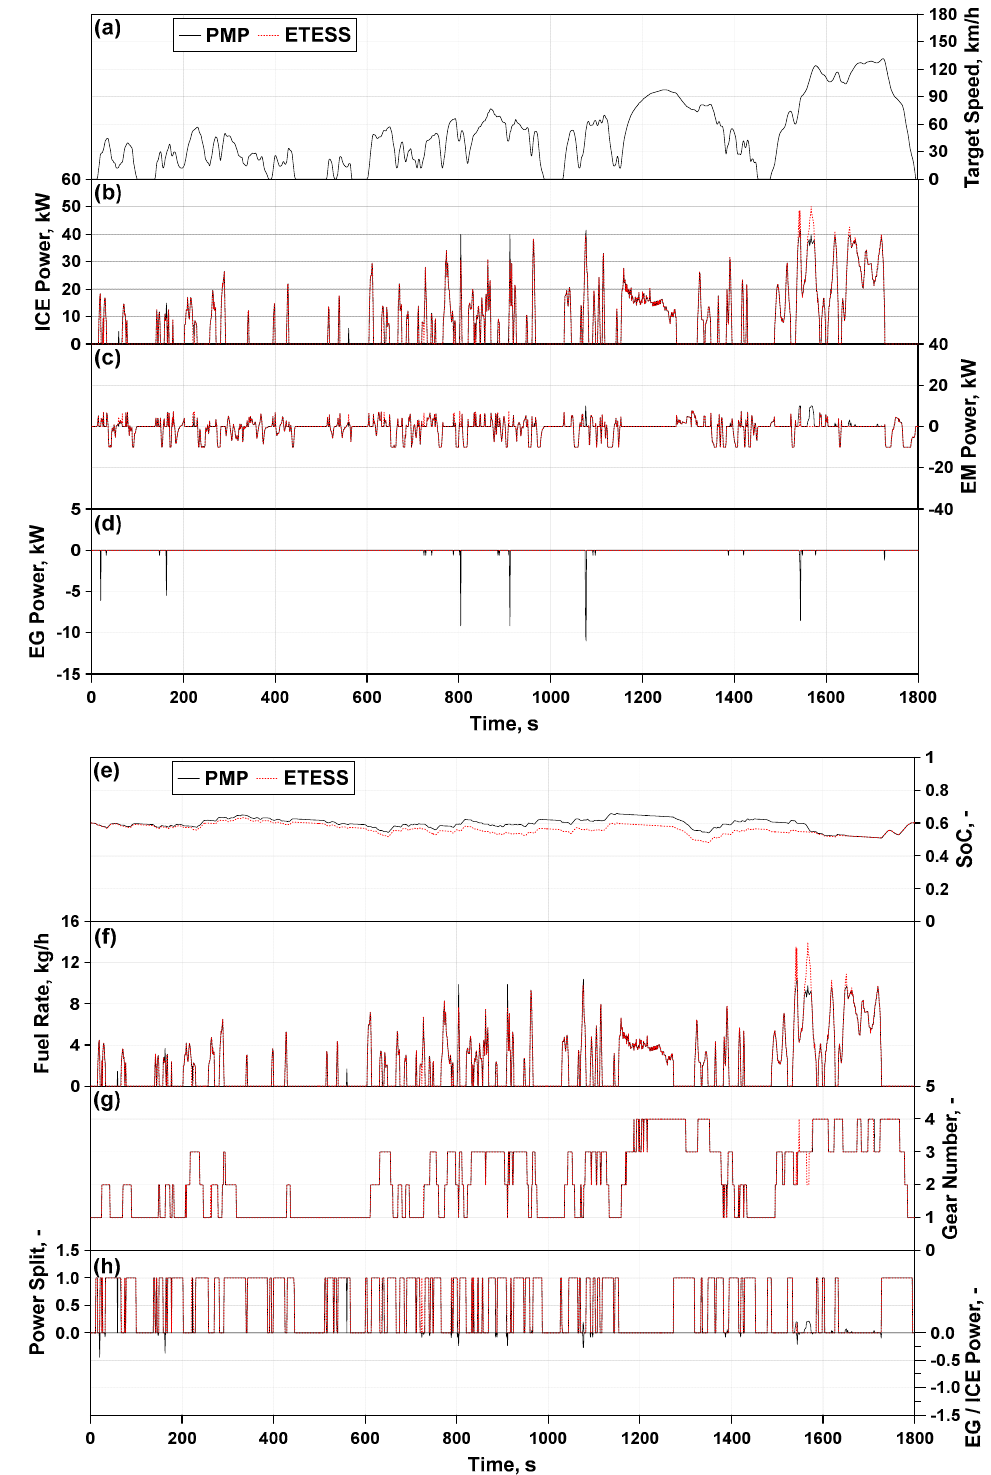
Figure 10. PMP-ETESS comparisons of ICE power ( b ), EM power ( c ), EG power ( d ), SoC ( e ), fuel rate ( f ), GB 1 number ( g ) and vehicle mode ( h ) along the WLTC (vehicle speed—( a ))—case #10.